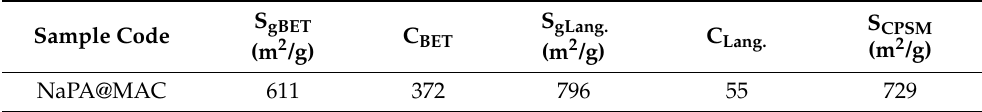
Table 2. Specific Surface Area (SSA) estimation derived from the classic models BET and Langmuir as well as from the CPSM